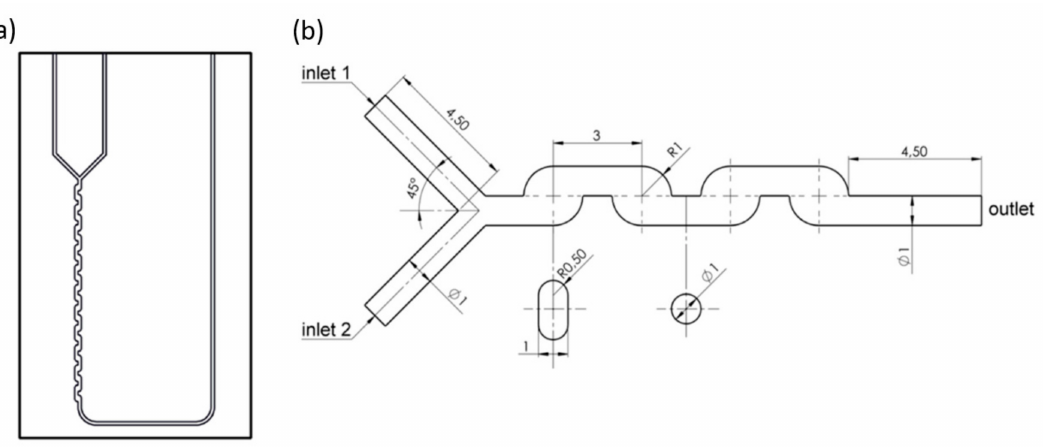
Figure 14. ( a ) Schematic representation of the microfluidic platform and ( b ) geometrical model of the chicane micromixer designed by Khaydarov et al. Reprinted from an open-access source